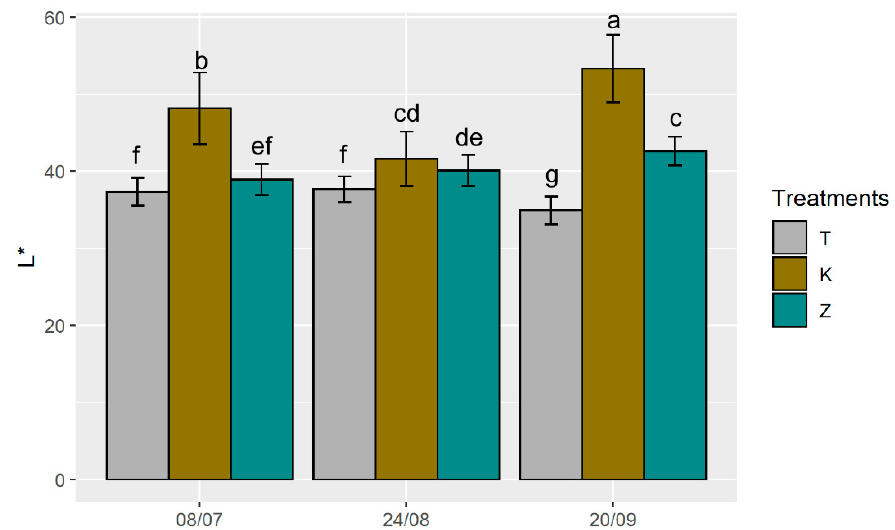
Figure 5. Changes in L*color values measured on the upper part of the leaves of T (control), K (kaolin) and Z (CHA-zeolitite) treatments. Error bars represent standard deviation. Different letters above the bars for each group of histograms indicate significant differences according to ANOVA and Tukey’s HSD test ( p < 0.05).